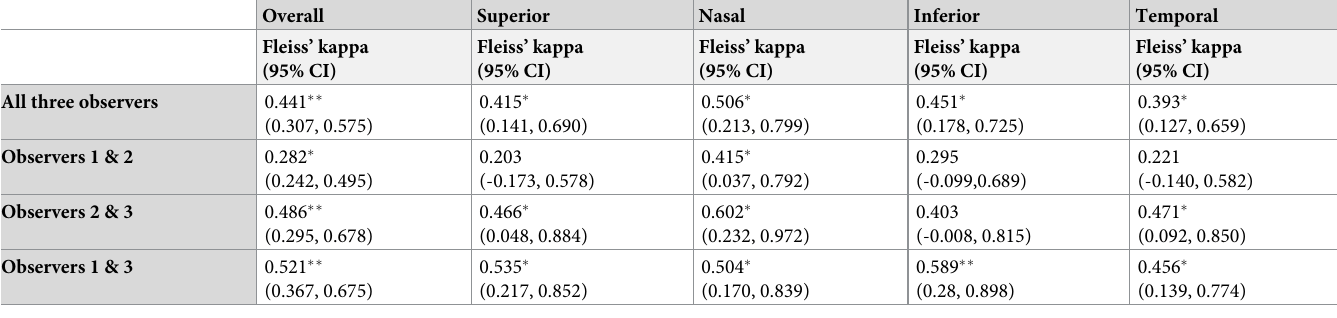
Table 3. Interobserver agreement in the classification of images as gradable or non-gradable.